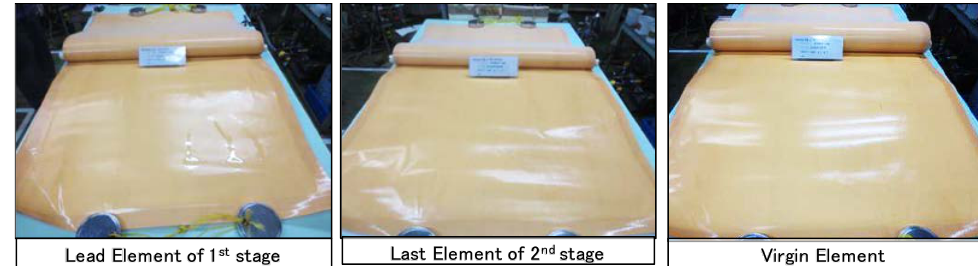
Figure 11. Surface conditions of the lead and last RO element (collection on 81st day of operation). Table 5. Membrane surface deposit condition and compositions. Lead Element Last Element (Example of Reached CIP Criteria) ***